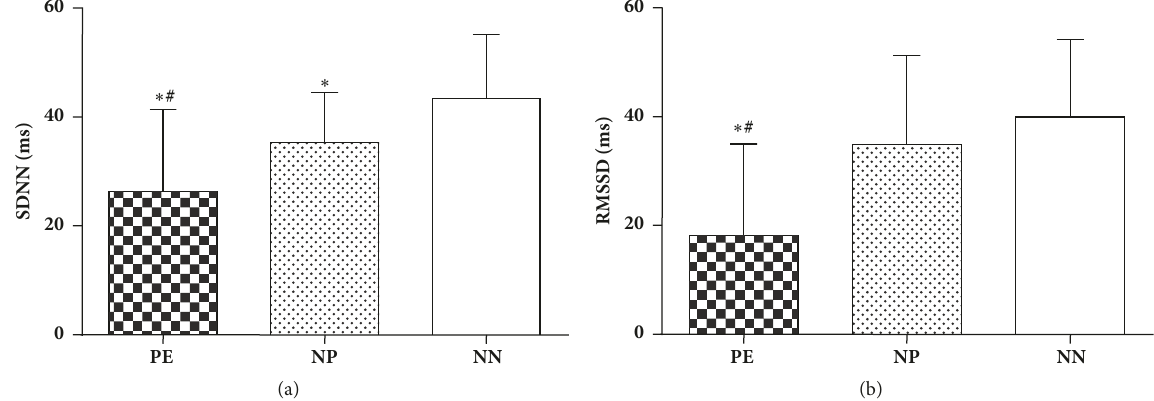
Figure 1: Comparison of (a)SDNN and (b)RMSSD values in 3 groups of subjects;PE, preeclampsia; NP, normotensive pregnant;NN, normal nonpregnant;SDNN,standarddeviationofnormalR-Rintervals;RMSSD,squarerootofmeansquareddifferencesofsuccessiveR-Rintervals. Values are mean ± SD (n=40). ∗ p < 0.05 versus normal nonpregnant females; # p < 0.05 versus normotensive pregnant